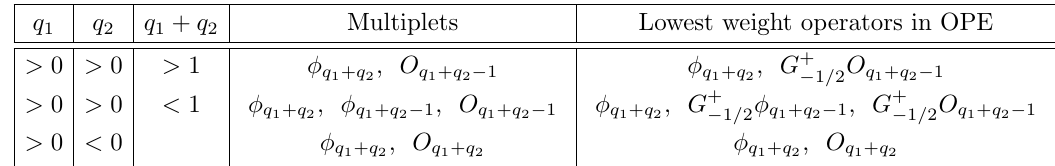
and (cid:30) q of R-charges 1 2